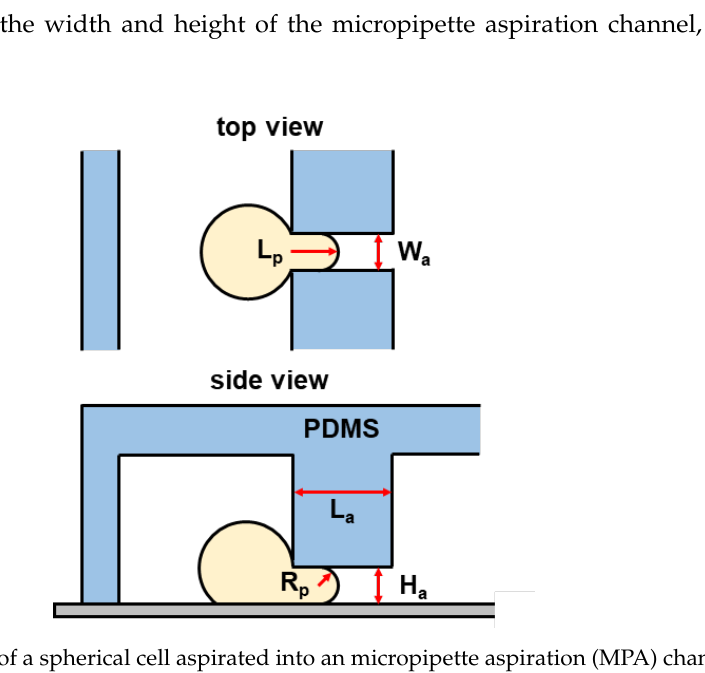
Figure 3. Schematic of a spherical cell aspirated into an micropipette aspiration (MPA) channel with a suction pressure ∆ p A . PDMS: